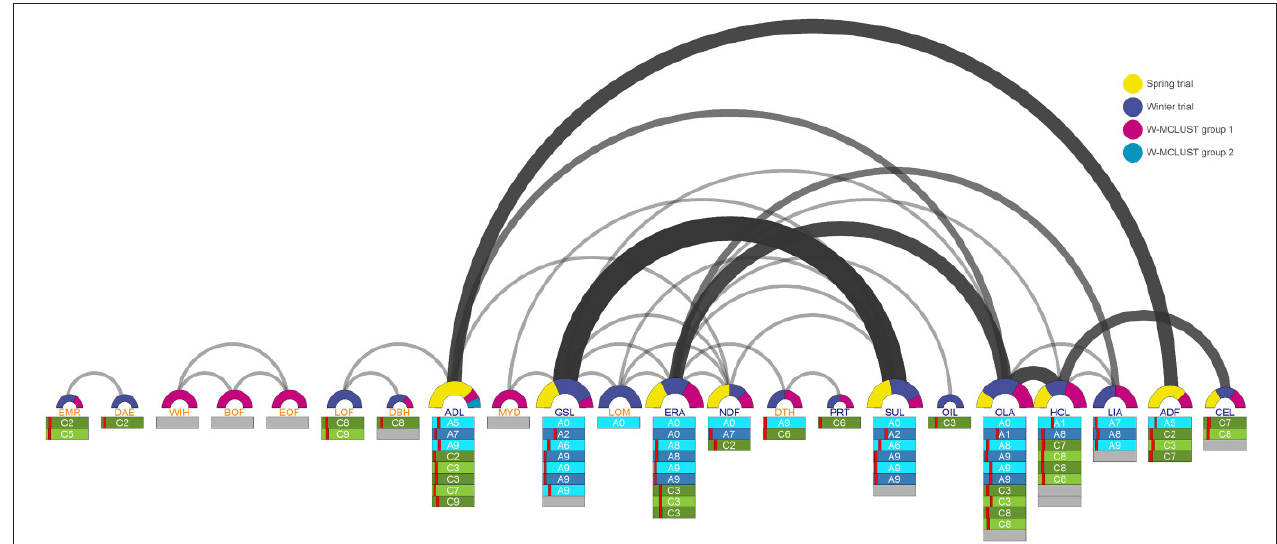
FIGURE 5 | Arcdiagram of co-localizing SNP-trait associations between two or more traits for the agronomic and seed quality traits. The width of the arcs as well as the size of the semicircles are related to the number of co-localizing SNP-trait associations between the connected traits. The colors of the semicircles represent the distribution of the co-localizing SNP-trait associations to the spring trial, winter trial, and the WR-MCLUST groups 1 and 2. The bars below the traits symbolize the chromosomes and the red dashes the position of the respective co-localizing SNP-trait associations on these chromosomes. The chromosomes of the A genome are colored blue and the chromosomes of the C genome green. Unknown chromosome positions are colored gray.